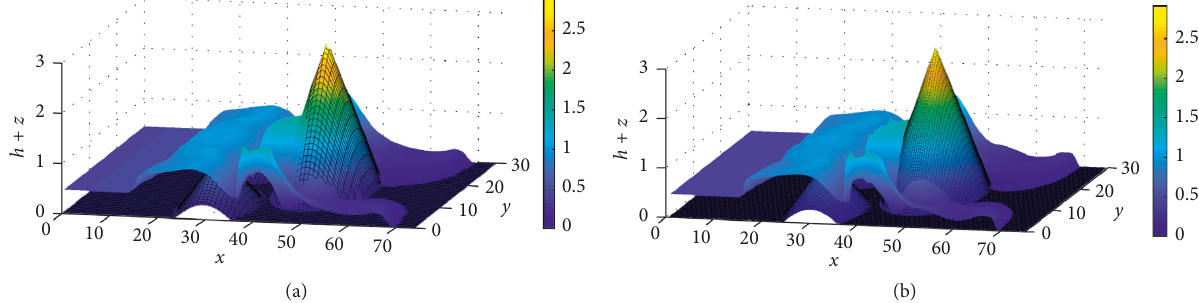
Figure 12: Water surface profile using 85